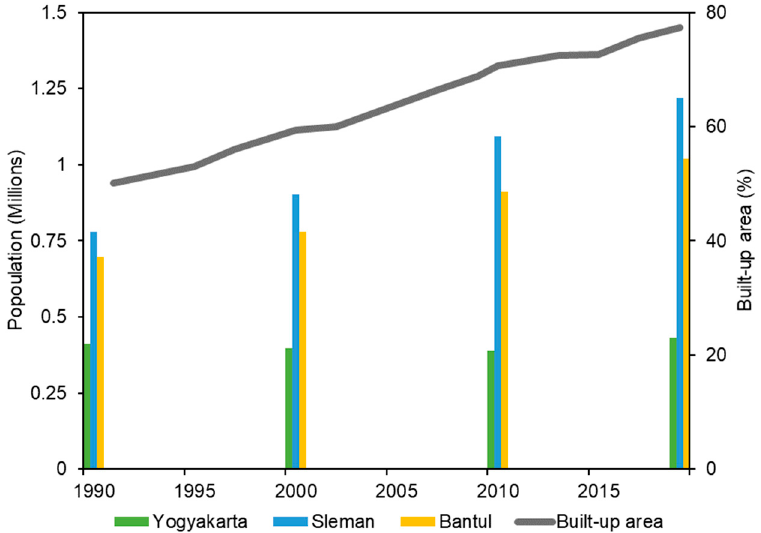
Figure 13. Growth of population density in Yogyakarta, Sleman, and Bantul compared to the expansion of the built-up area. Population data were adapted from Badan Pusat Statistik [103] and Kuncoro [102].